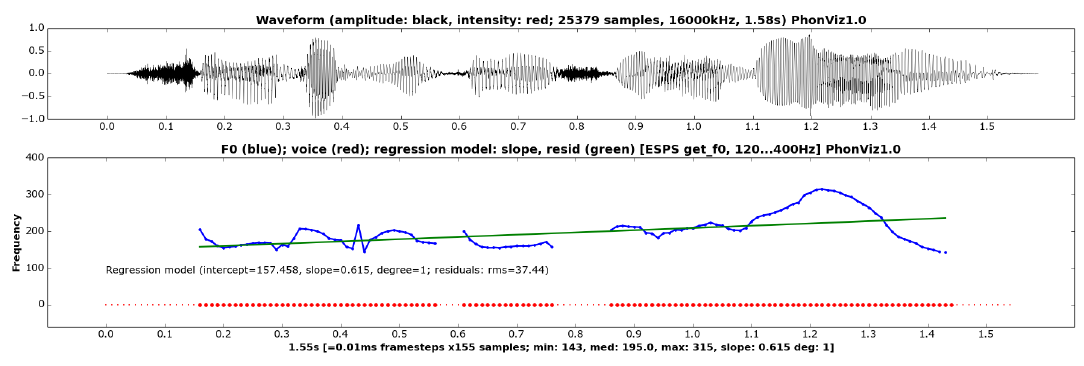
Figure 8: Waveform, pitch trace and voice trace of a BBC newscast extract (female voice, Aix-MARSEC corpus A0103B): “shared it with those who had NONE”, with superimposed linear regression pitchslope line as illustration of positive slope (inclination rather than